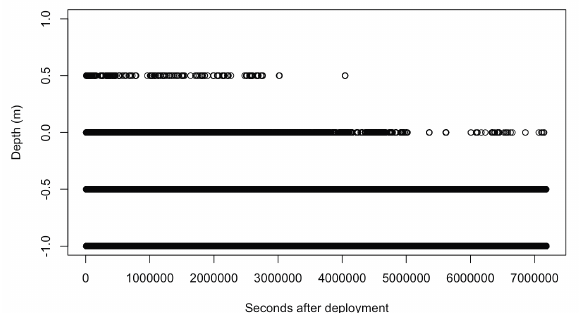
Figure 5: The surface (0.5–2 m) hits from #3965 from >7.000.000 depth recordings. The resolution is 0.5 m.